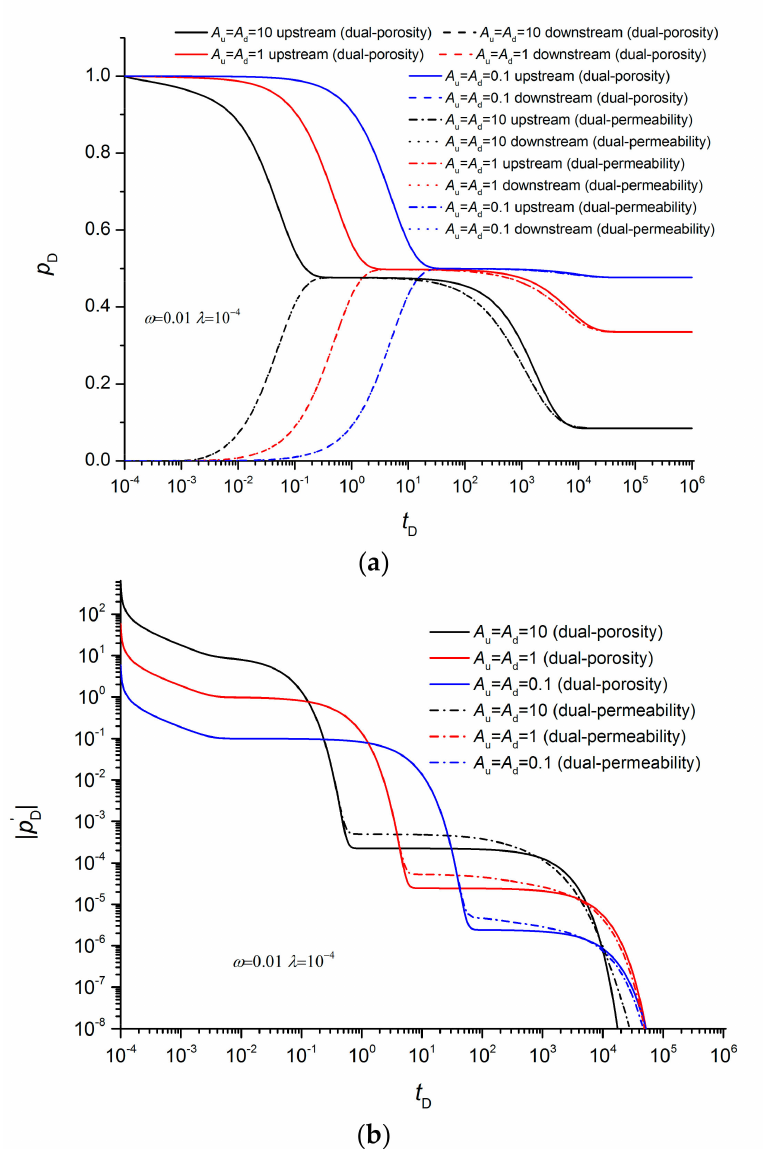
Figure 6. E ff ect of vessel volumes on pulse decay tests for dual-permeability. ( a ) Pressure history. ( b ) Pressure derivative